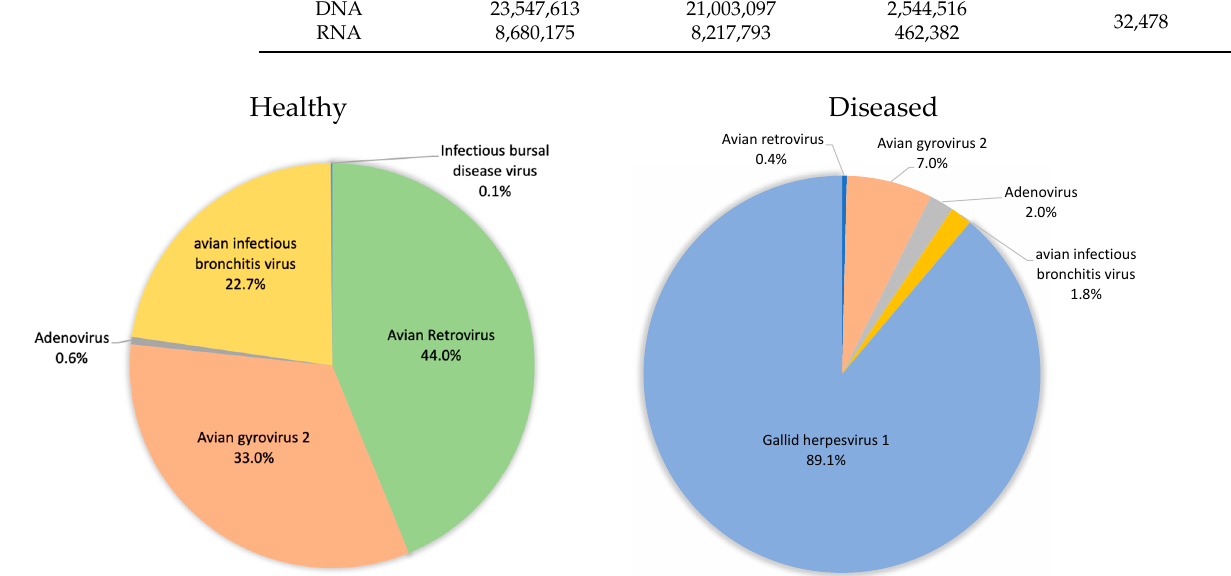
Figure 8. Changes in the eukaryotic viral microbiome associated with avian respiratory disease.